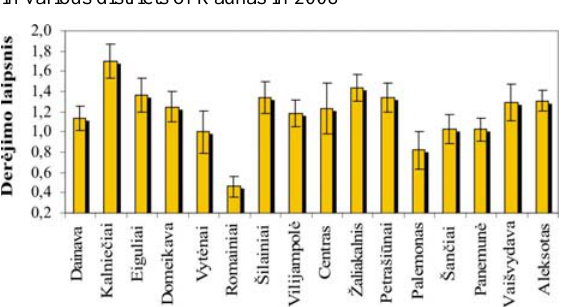
Fig. 6. Average foliage dechromation of sampled trees in various districts of Kaunas in 2008